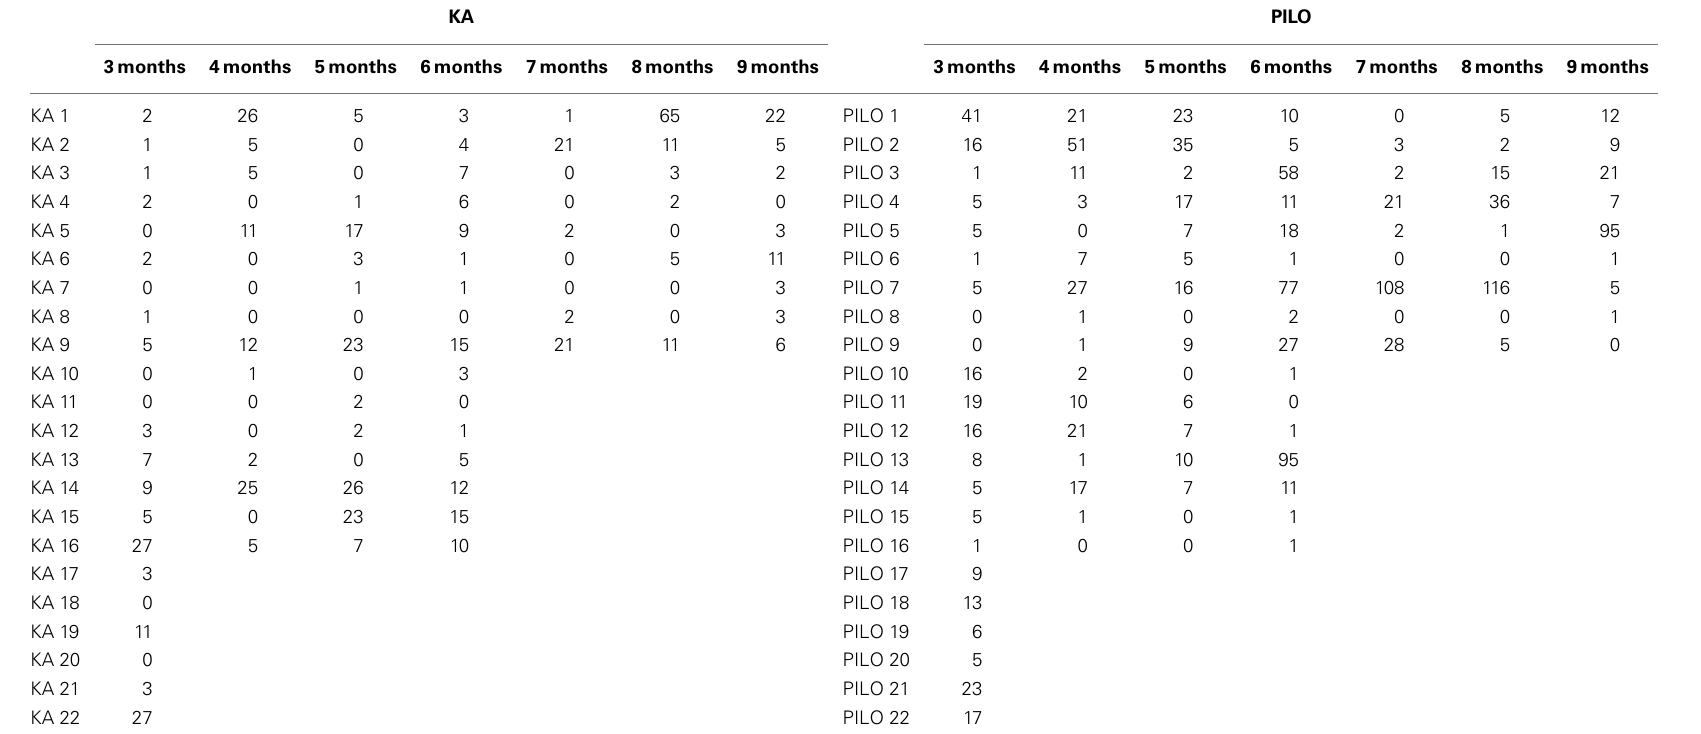
Table 2 |Absolute number of spontaneous seizures a after KA- or PILO-induced SE